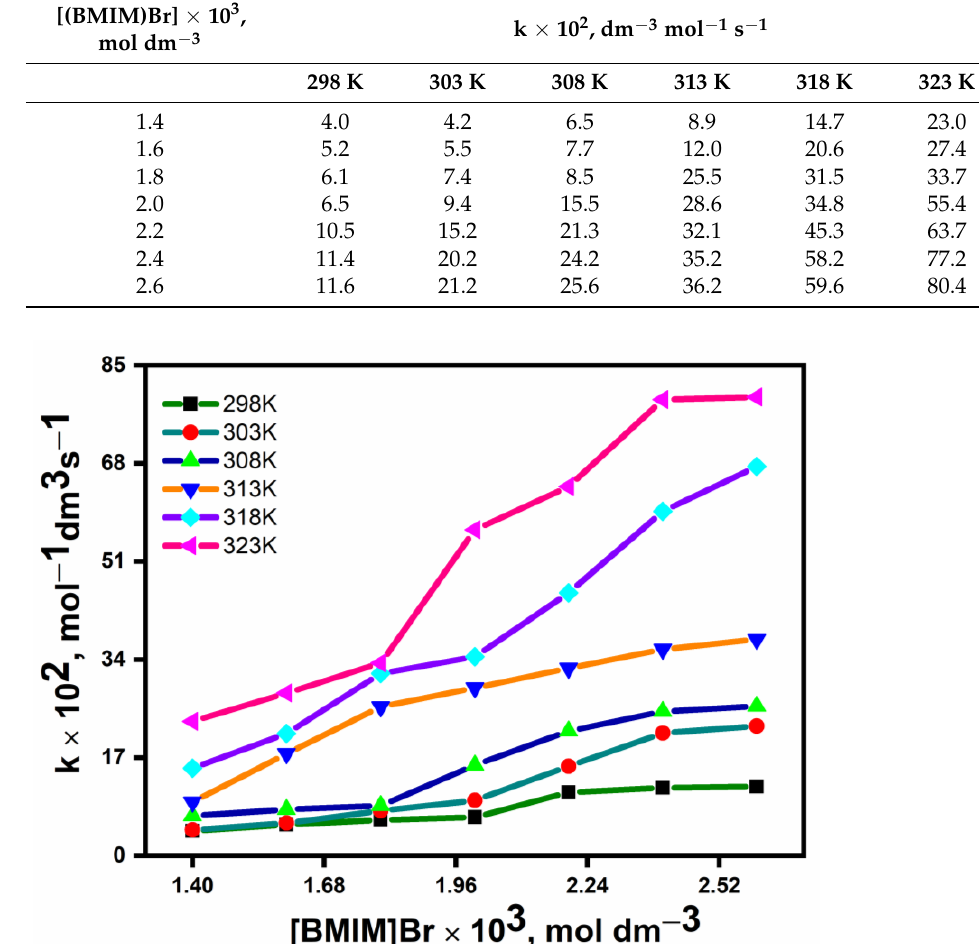
Figure 2. Plot of k against [BMIM]Br for cis-[Co(ip) 2 (C 12 H 25 NH 2 ) 2 ](ClO 4 ) 3 at various temperatures; cis-[Co(ip) 2 (C 12 H 25 NH 2 ) 2 ](ClO 4 ) 3 = 4 × 10 − 4 mol dm − 3 , μ = 1.0 mol dm − 3 , [Fe(CN) 6 ] 4− = 0.01 mol dm − 3 .